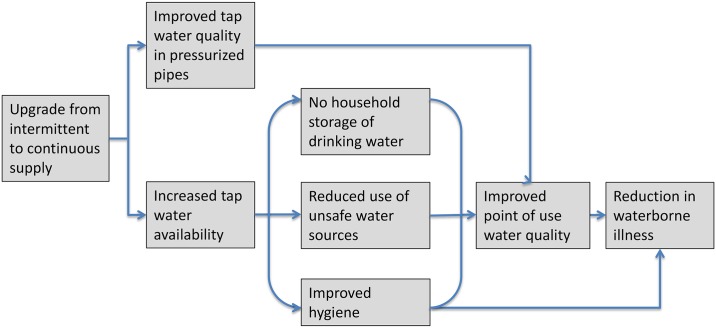
Causal chain between upgrading from intermittent to continuous water supply and reduction in waterborne illness.Upgrading from intermittent to continuous water supply is expected to be associated with reduced waterborne illness through improved tap water quality and increased water availability, which, in turn, is expected to eliminate household storage of drinking water, reduce water use from unsafe nonmunicipal sources, and improve hygiene practices.